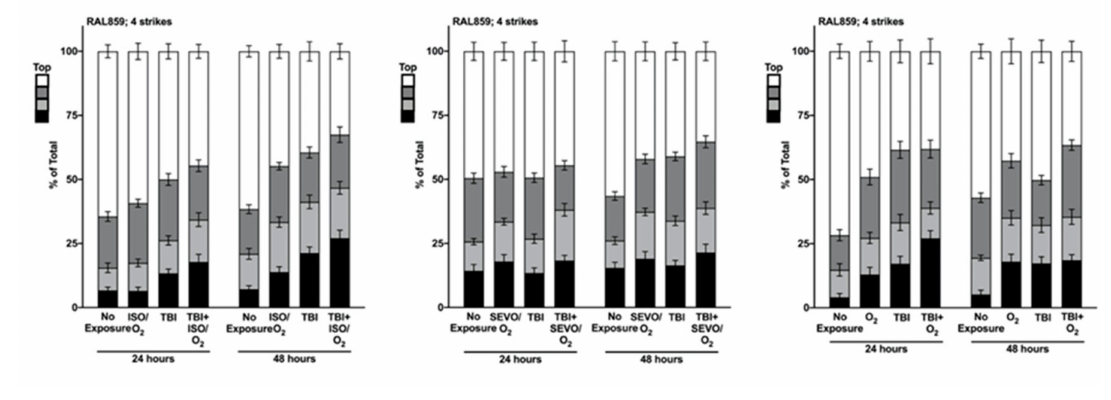
Figure A8. RAL859.